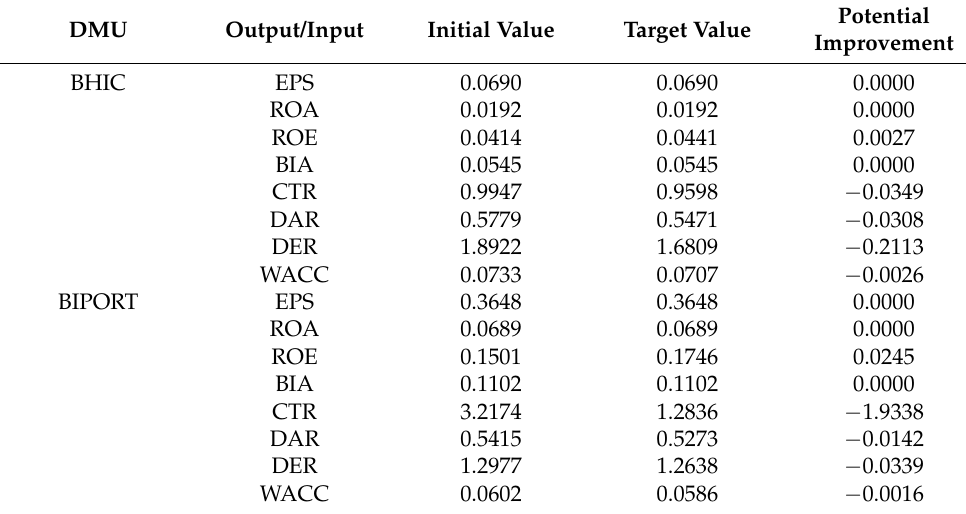
Table 5. Potential improvement for inefficient